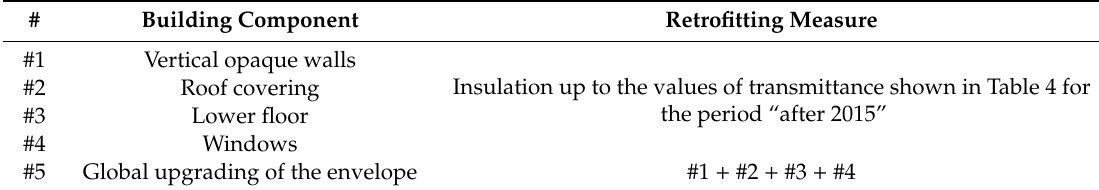
Table 1. Energy retrofitting measures for the building